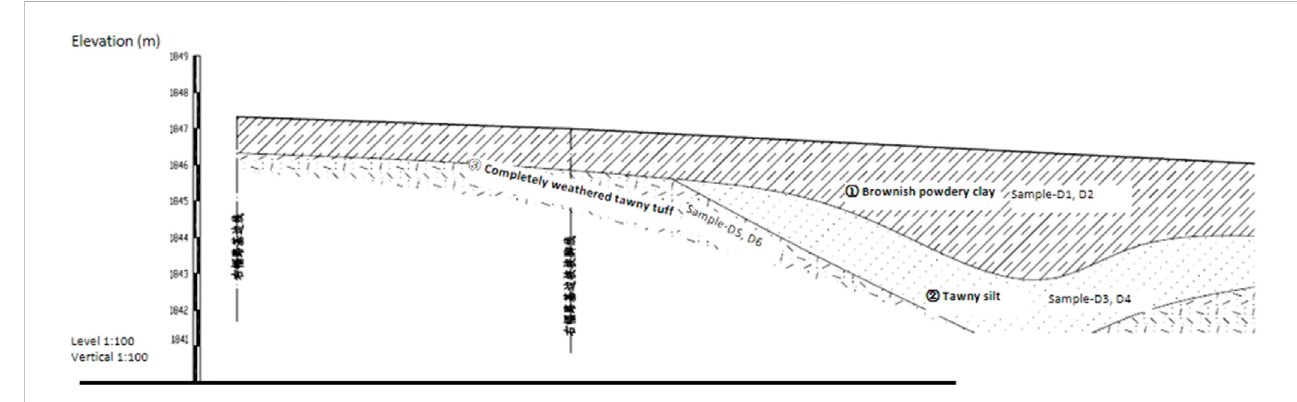
FIGURE 12 Engineering geological pro fi le of the TC3